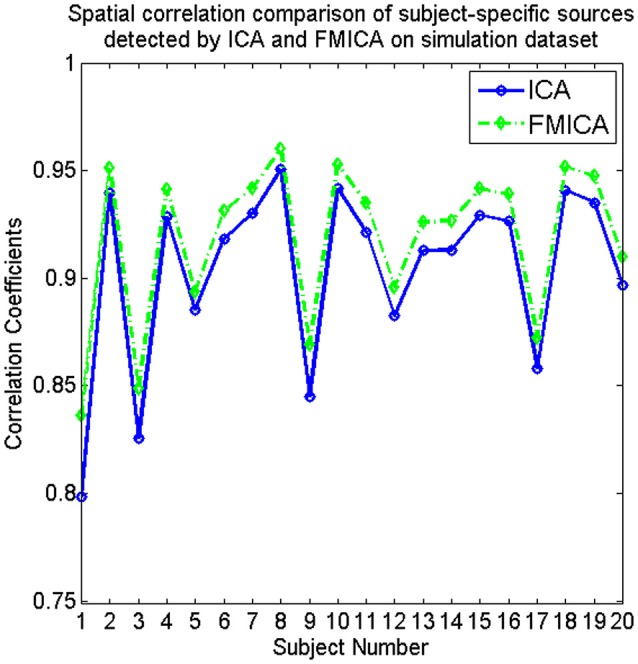
The comparative curves of spatial correlation regarding the subject-specific sources identified by ICA and FMICA, respectively, for the simulated 20 subjects on simulation dataset.